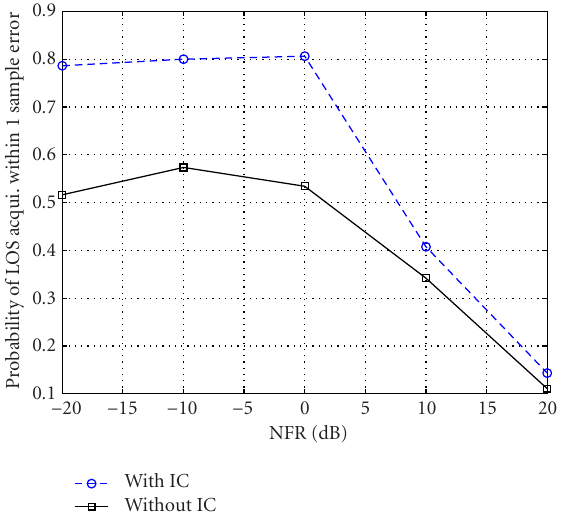
Figure 4: Probability of first arriving path acquisition within 1 sam- ple error with and without IC. Three closely spaced fading channel paths, N BS = 4, p R = 0 . 9, E b /N 0 = 8dB, S F = 256, N s = 8, N u = 32, N rand =